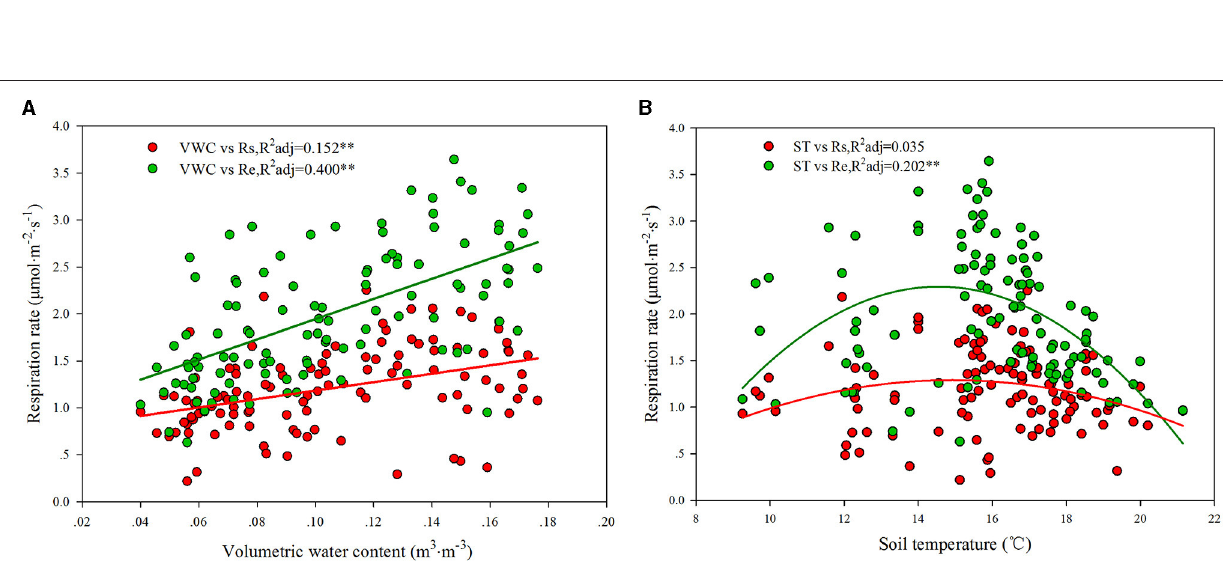
Frontiers in Ecology and Evolution |